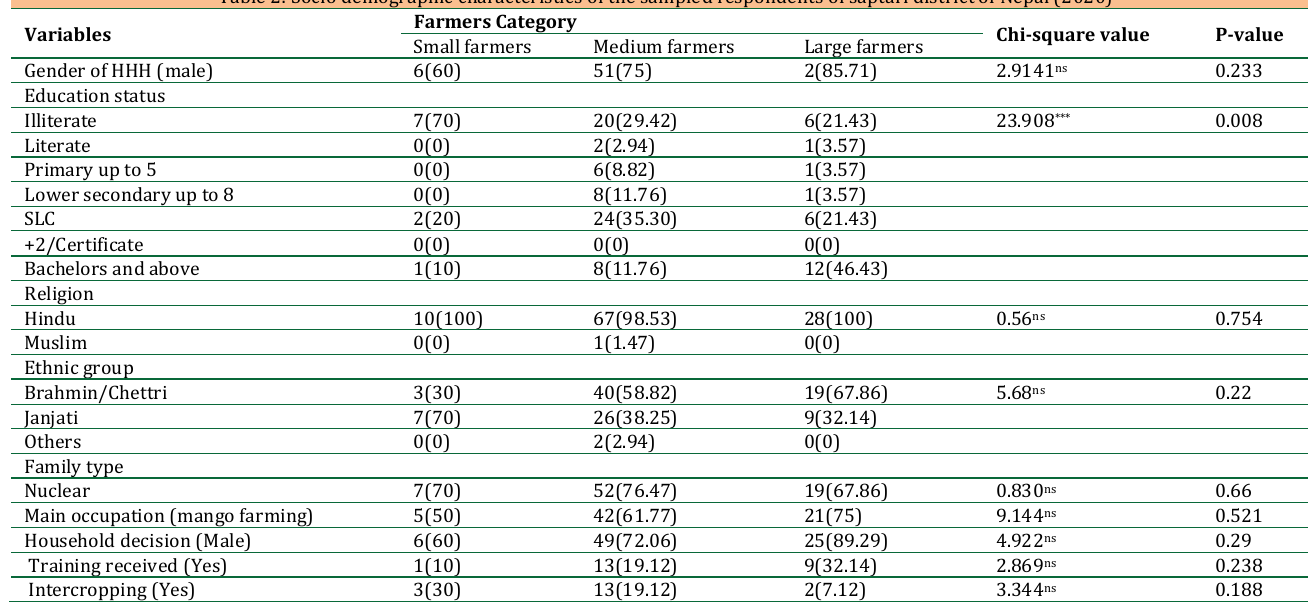
Table 2: Socio demographic characteristics of the sampled respondents of saptari district of Nepal (2020)